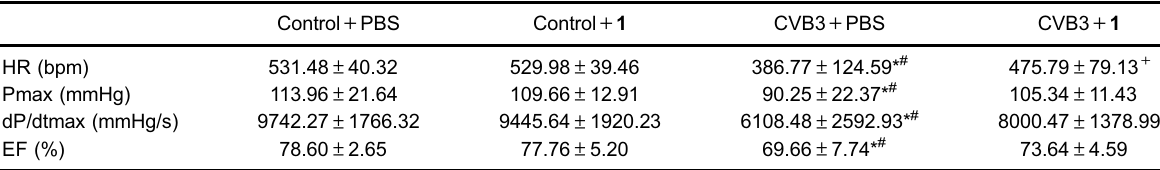
Table 3. Hemodynamic data of